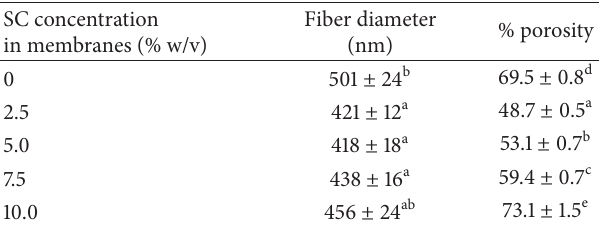
Table 2: Fiber diameter and percentage of porosity of the five types of PLCL-SC membranes at various concentration of SC. Statistical difference is indicated by lowercase letters (a, b, c, d and e) ( 𝑝 ≤ 0.05 ).